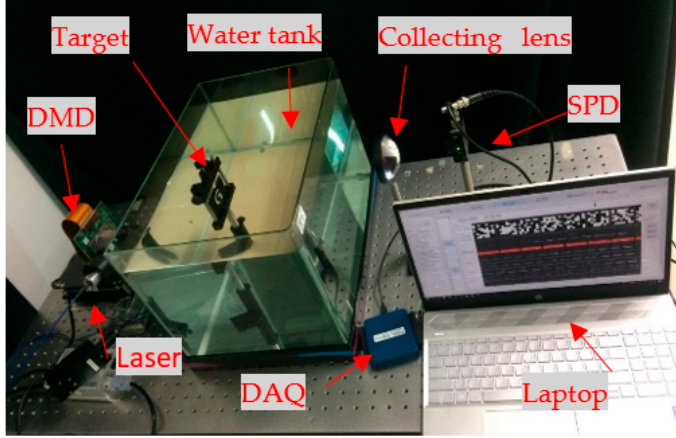
Figure 8. Experimental setup implemented in our lab environment.